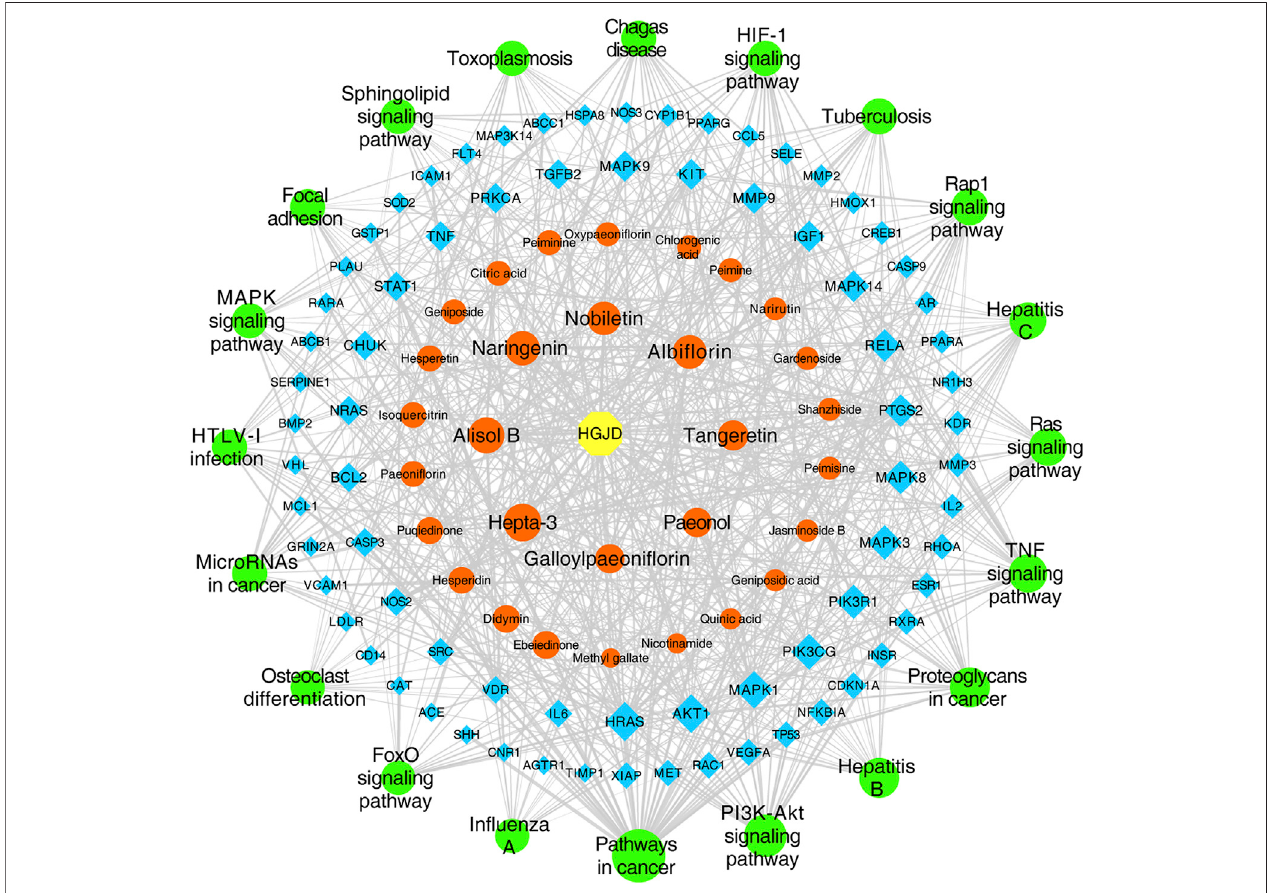
FIGURE 5 | Network of drug components-targets-pathways. The yellow hexagon node represents drug, the orange round shape nodes represent absorbed ingredients in blood, the blue diamonds represent targets, the green round shape nodes represent pathways, and the edges represent the interactions between them. The size of nodes is proportional to their degree